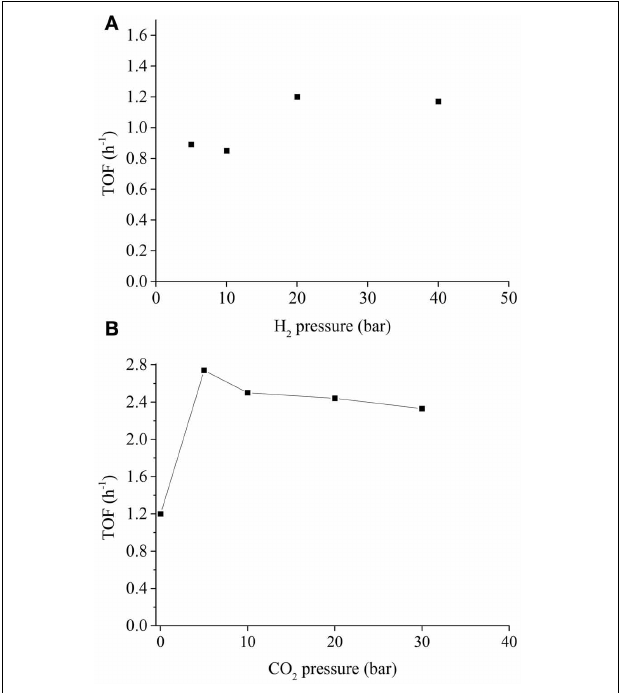
FIGURE 4 | (A) TOF as a function of H 2 pressure. Reaction condition: 0.012 mol NaHCO 3 , 1.2mmol Ni 7 Pd 3 , 0.024mol PVP, 40ml H 2 O, 80 ◦ C, 2h; (B) TOF as a function of CO 2 pressure. Reaction condition: 0.012mol